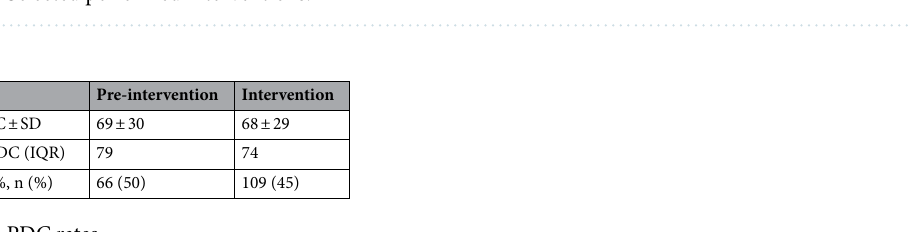
Table 2. Selected performed interventions.